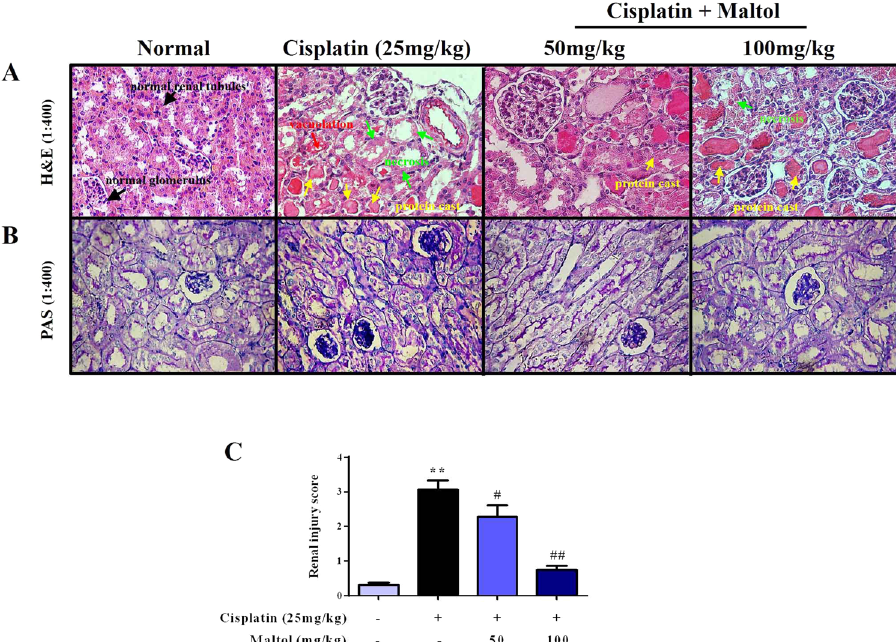
Figure 2. Maltol attenuated cisplatin-induced morphological changes. ( A , B ) H&E staining and PAS stain of kidney sections from normal group, cisplatin group, maltol (50 mg/kg) + cisplatin group and maltol (100 mg/ kg) + cisplatin group. Note: The condensation of the cell necrosis (green arrow) and protein cast (yellow arrow) in cisplatin mice. Red arrows refer to vacuolization of the renal cortex (magnification × 400). The renal injury score ( C ) was determined. All values were expressed as mean ± S.D. ** p < 0.01 vs . normal group; # p < 0.05, ## p < 0.01 vs . cisplatin group.